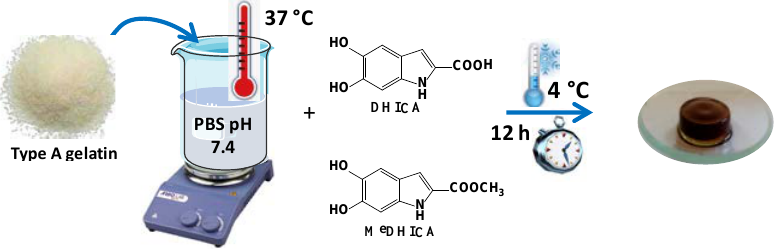
Figure 1. Preparation of gelatin and loading of indole compounds.